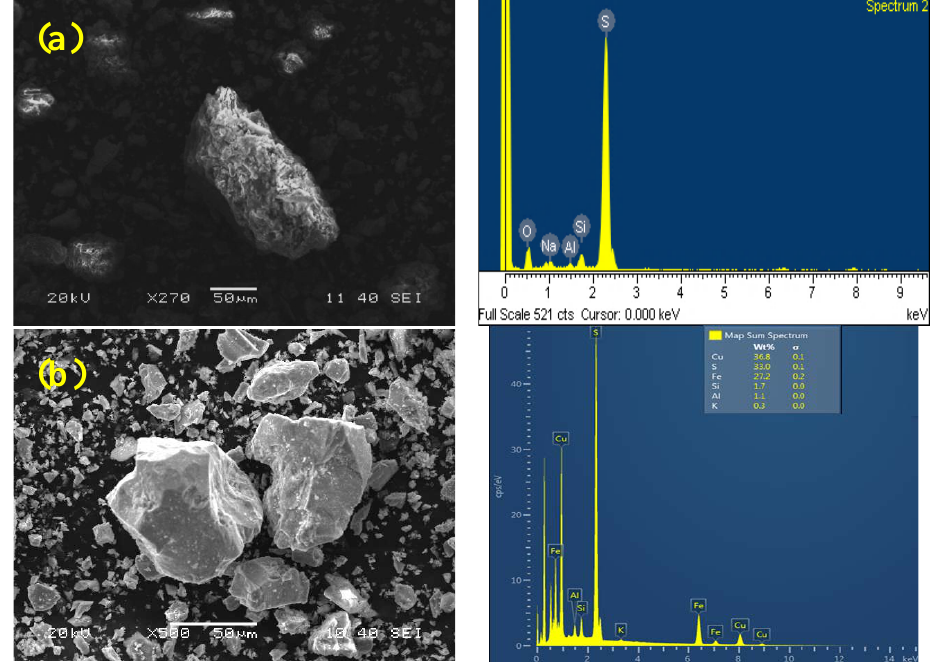
Figure 4. SEM micrographs and EDS spectrums of ( a ) residue (Test 4) and ( b ) Initial chalcopyrite concentrate sample.